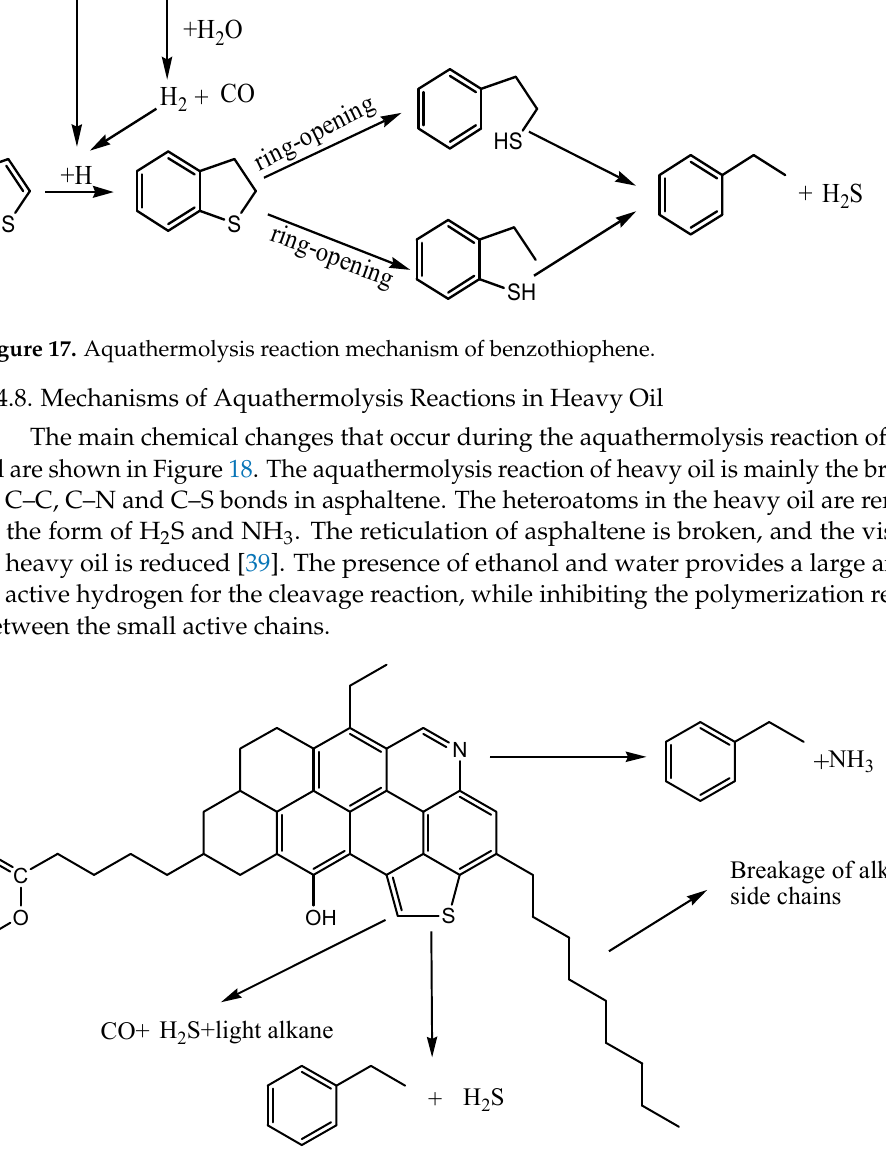
Figure 18. Chemical changes occurring in the aquathermolysis reaction of heavy oil.